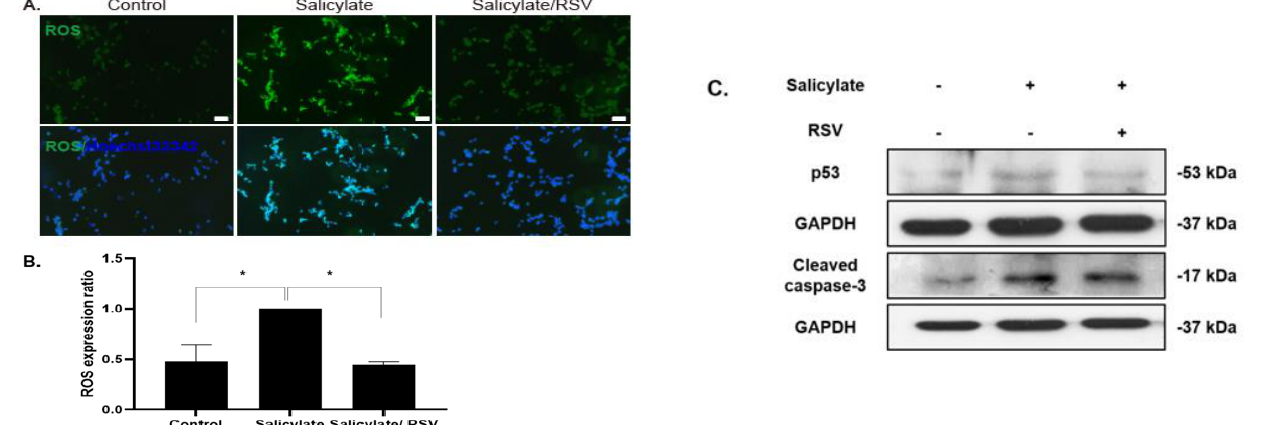
Figure 3. Pretreatment of resveratrol (RSV) reduced intracellular reactive oxygen species (ROS) levels in salicylate-treated neuronal cells. ROS levels increased with salicylate treatment, but decreased in RSV-pretreated neuronal cells as observed by fluorescence microscopy ( A ). The ROS levels were quantified using ImageJ ( B ); * p < 0.05, mean ± SD. Salicylate increased the expression of cleaved caspase-3 and p53, which was deceased in RSV-pretreated cells ( C ); scale bar = 100 µm. GAPDH was used as the internal standard. Scale bar = 100 um.